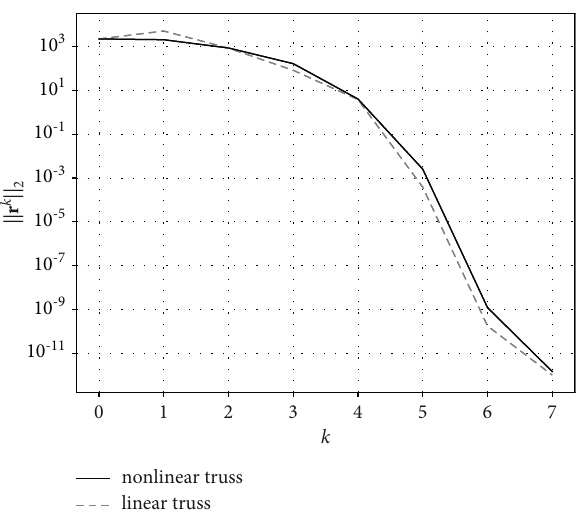
Figure 10: Convergence of the 3D 3-bar system.